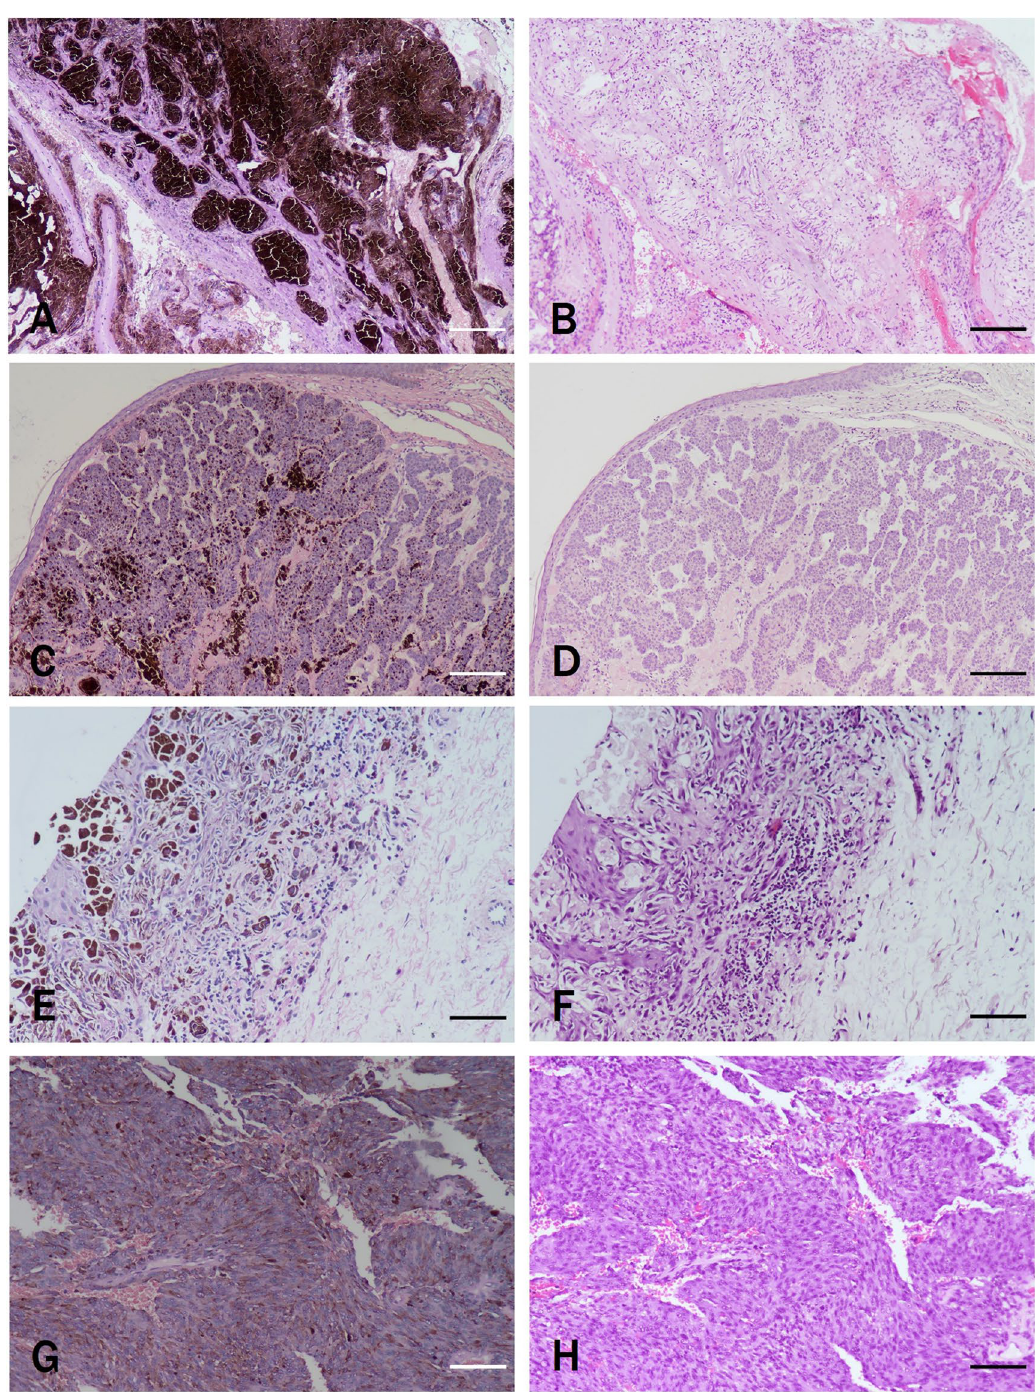
Figure 3. Different types of melanin after treatment with 1% TCCA typical pictures of pathological sections with different melanin types treated with 1% TCCA and stained with "Restored pH" HE method. ( A ) Central melanocytoma: conventional HE staining without melanin bleaching. ( B ) Central melanocytoma: HE staining of "Restored pH" after melanin bleaching. ( C ) Skin adnexal tumor: conventional HE staining without melanin bleaching. ( D ) Skin adnexal tumor: HE staining of "Restored pH" after melanin bleaching. ( E ) Compound nevus: conventional HE staining without melanin bleaching. ( F ) Compound nevus: HE staining of "Restored pH" after melanin bleaching. ( G ) Malignant melanoma: conventional HE staining without melanin bleaching. ( H ) Malignant melanoma: HE staining of "Restored pH" after melanin bleaching. Scale bar means 100